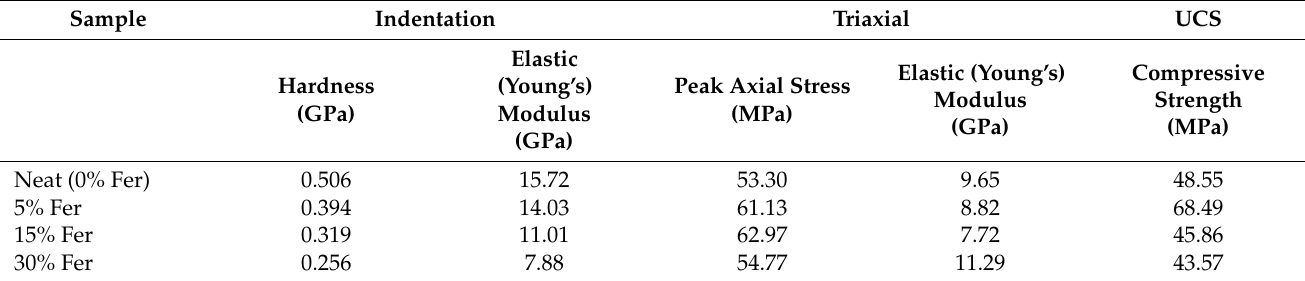
Table 3. Summary of mechanical tests for 16.4 ppg neat Class-H, and 5%, 15%, and 30% ferrierite- added Class-H cement